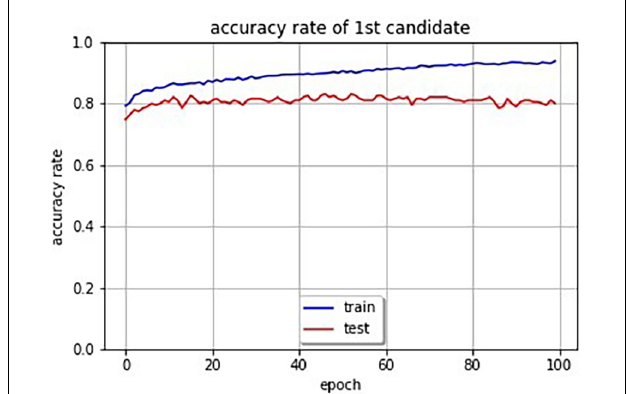
FIGURE 4 | Accuracy rate curves of first candidate SSWs (the blue line is training data and the red line is test data).